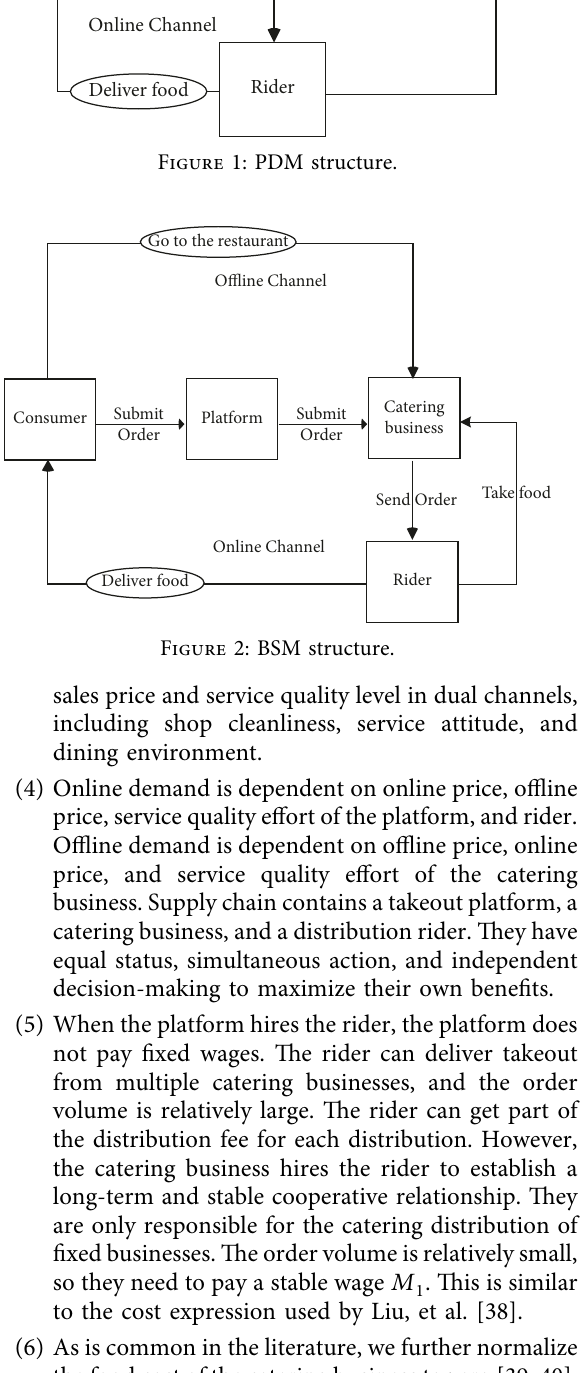
Figure 1: PDM structure.